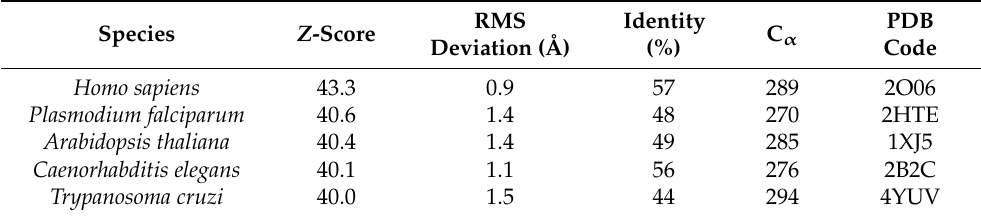
Table 1. Structural similarity comparison for homologous structures of spermidine synthase among five species using Dali a .